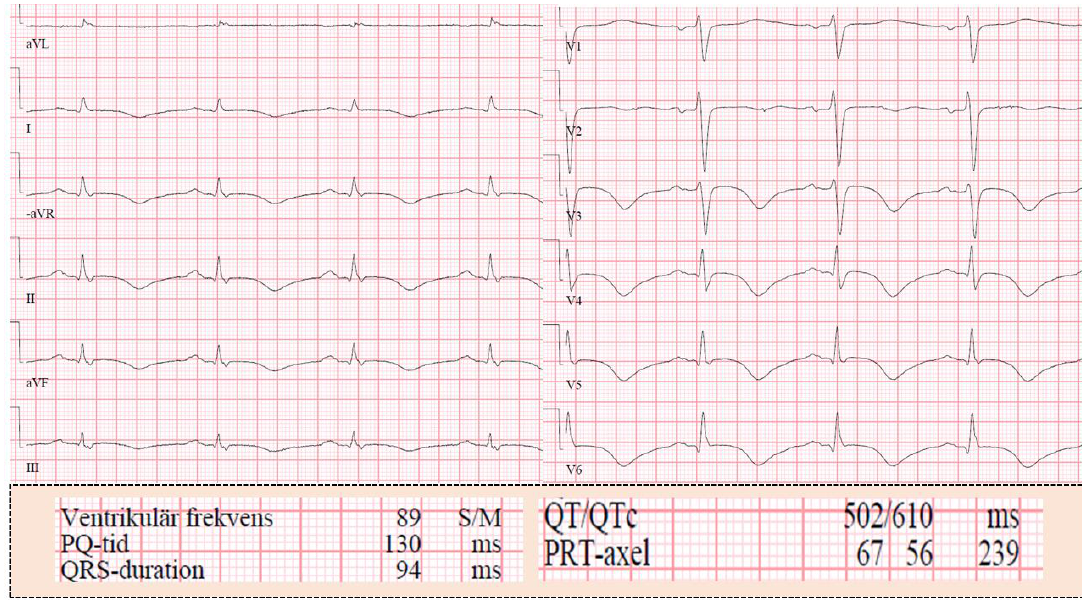
Figure 1. Twelve-lead electrocardiogram (ECG) in a patient with pheochromocytoma-induced mid apical takotsubo syndrome (TS). The ECG reveals general T-wave inversions with marked prolongation of the corrected QT interval 610 msec.